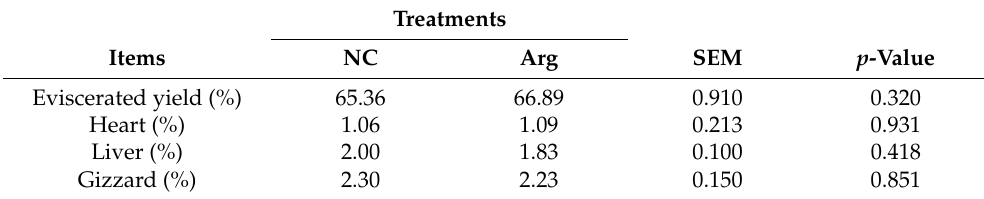
Table 4. Effects of in ovo feeding of L-arginine on carcass traits of slow-growing chickens on day 63. Treatments